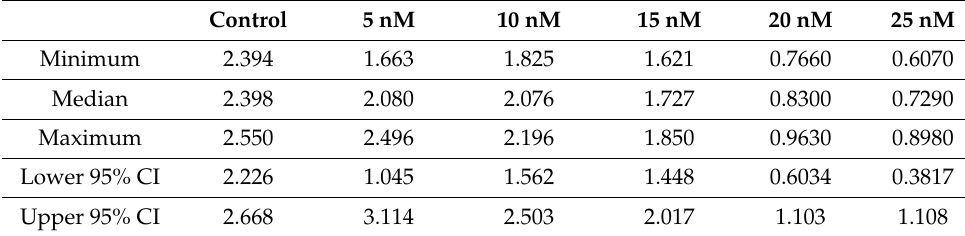
Table 1. CHIR99021 different doses cytotoxicity over hDPSCs at day 3.